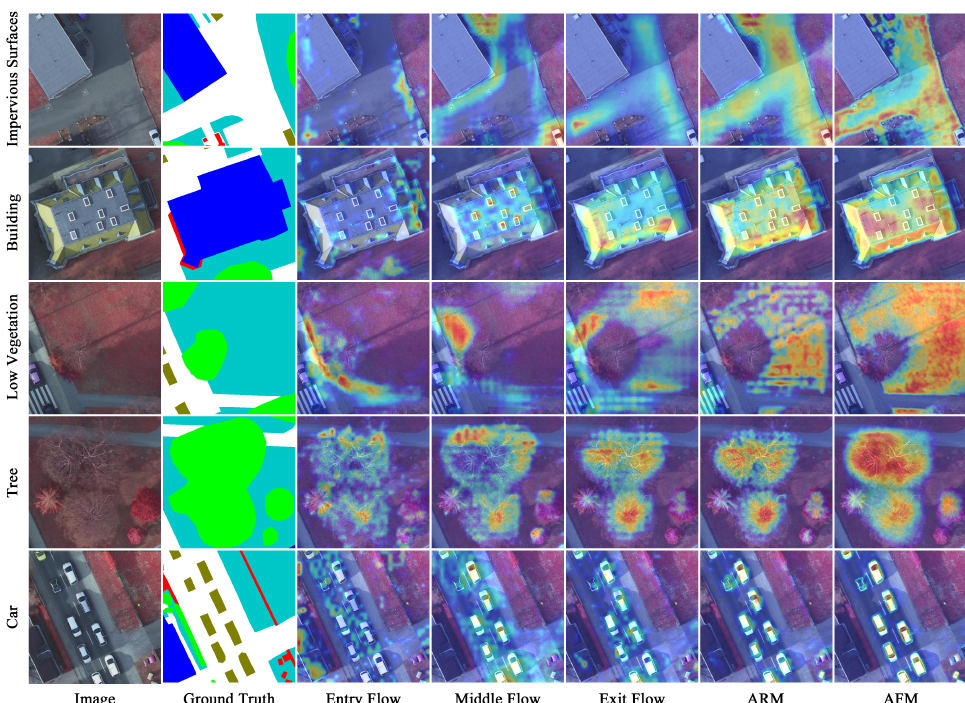
Figure 16. Visualization analysis of XANet on the Postdam